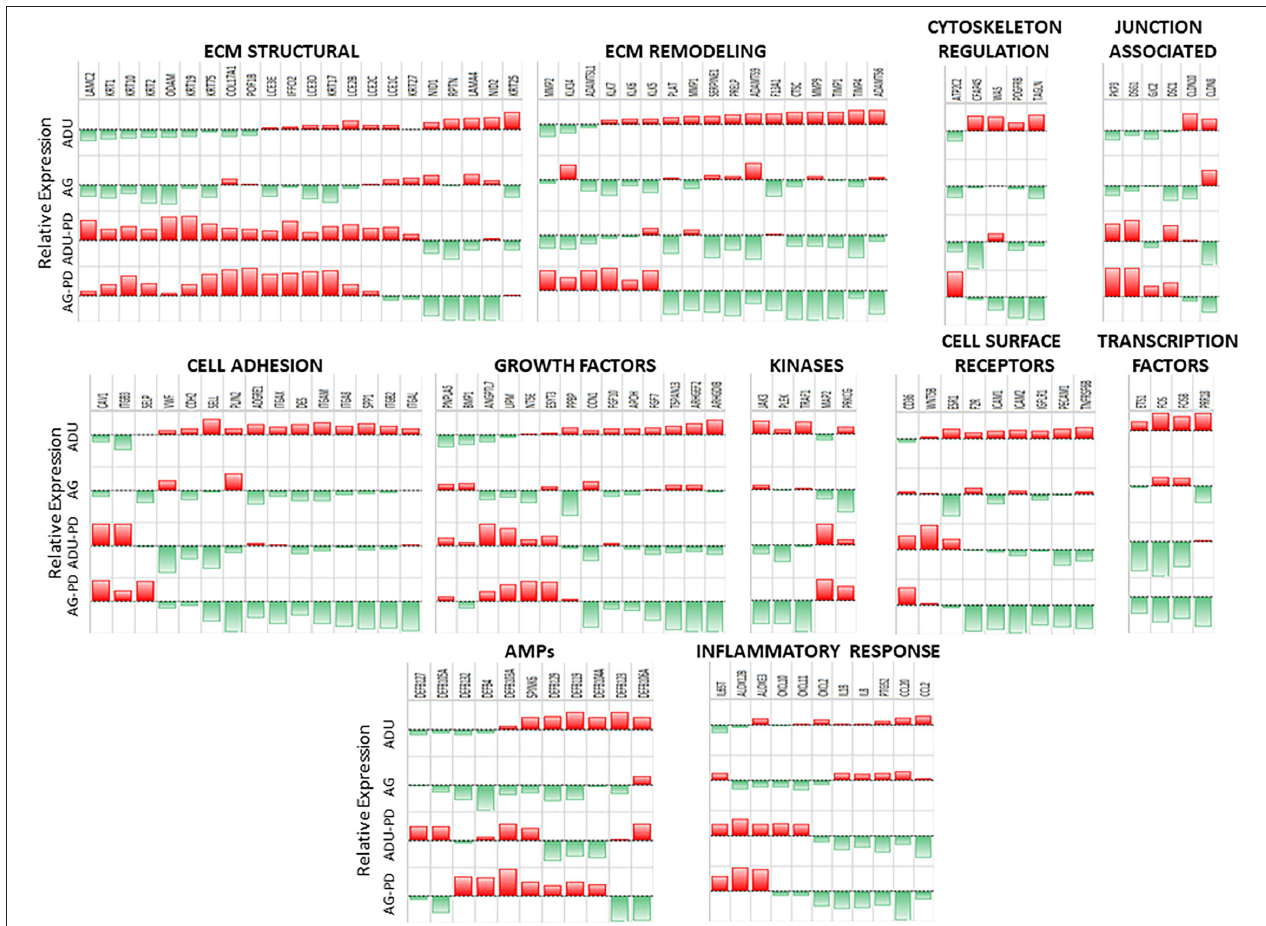
FIGURE 2 | Heatmap of z-scores of fold differences in gene expression in adult and aged healthy and adult and aged periodontitis samples. The z-scores were determined across groups and within each gene. Genes are grouped into the 11 major categories. Red color and bar height denotes a low z-score, while green color and bar height signify a high z-score for that group and